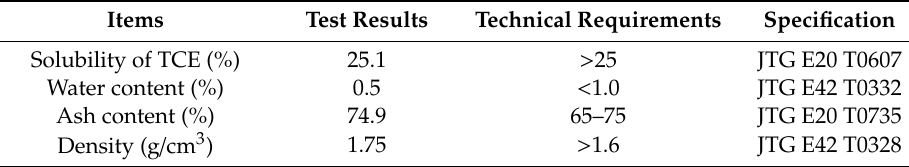
Table 2. Technical properties of Buton-rock asphalt